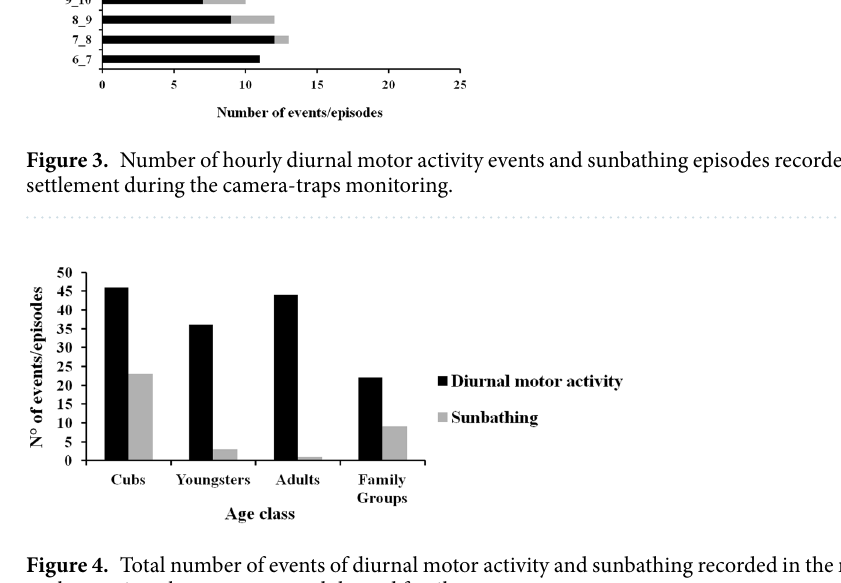
Figure 4. Total number of events of diurnal motor activity and sunbathing recorded in the monitored settlement in cubs, youngsters, adults and family